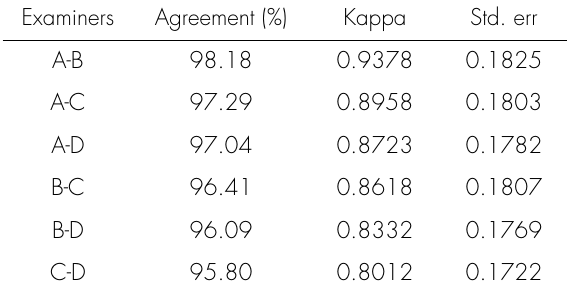
Table IX. Inter-examiner agreement and Kappa of the IOTN-AC for the photographs of study models. Examiners